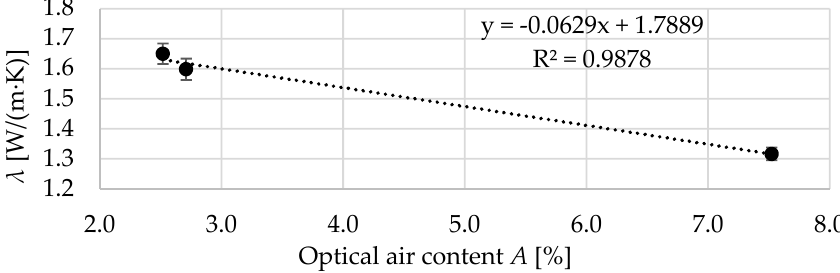
Figure 17. The relation between the optical air content A and the thermal conductivity λ .